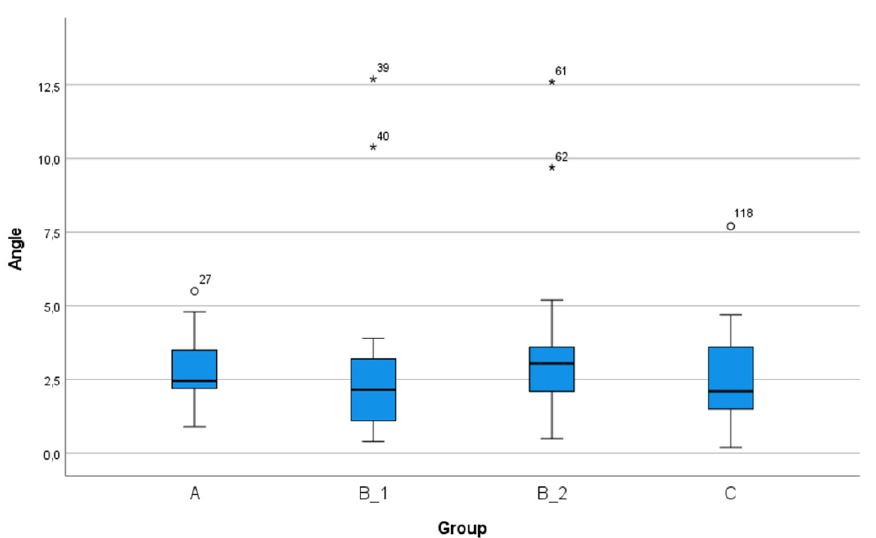
Figure 6. The angular deviations achieved by each process chain. No significant differences were observed between the process chains. Process chain B_1: CBCT without a reference marker and intraoral digitization with and without a reference marker. Process chain B_2: CBCT without a reference marker and conventional impression and extraoral digitization with and without a refer- ence marker. Process chain C: CBCT without a reference marker and intraoral digitization without a reference marker.